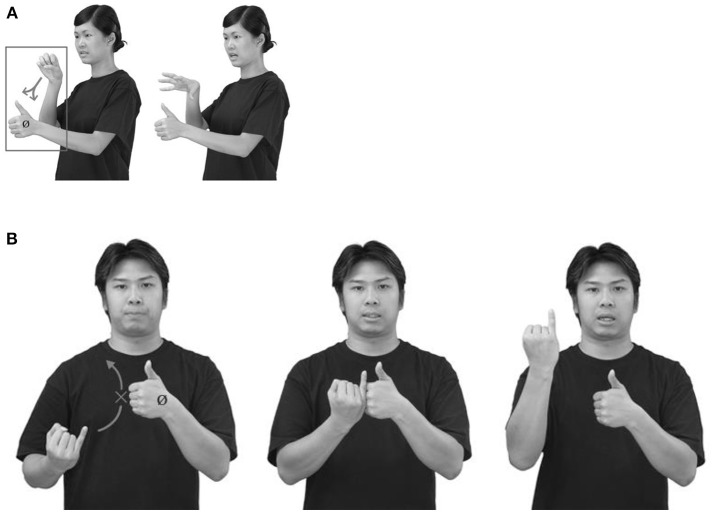
(A) SCOLD, (B) REBEL.